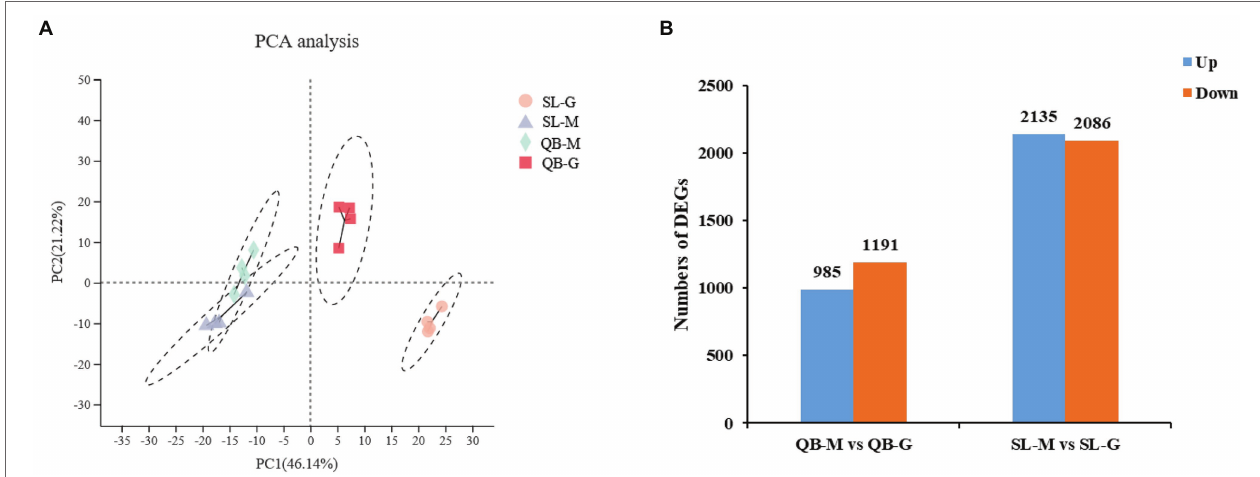
FIGURE 5 | Statistical analysis of sequencing data of SL-M, SL-G, QB-M, and QB-G. (A) Principal component analysis based on gene expression. See Figure 3B for figure interpretation notes. (B) Statistics of differentially expressed genes (DEGs) between the seeds at the early germination stage and mature stage. The horizontal axis represents the comparison of seed germination at different sites, blue group represents upregulation, orange group represents downregulation, and the vertical axis represents the number of DEGs.